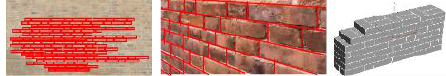
Figure 8. Brick laying of the wall of Puzhou